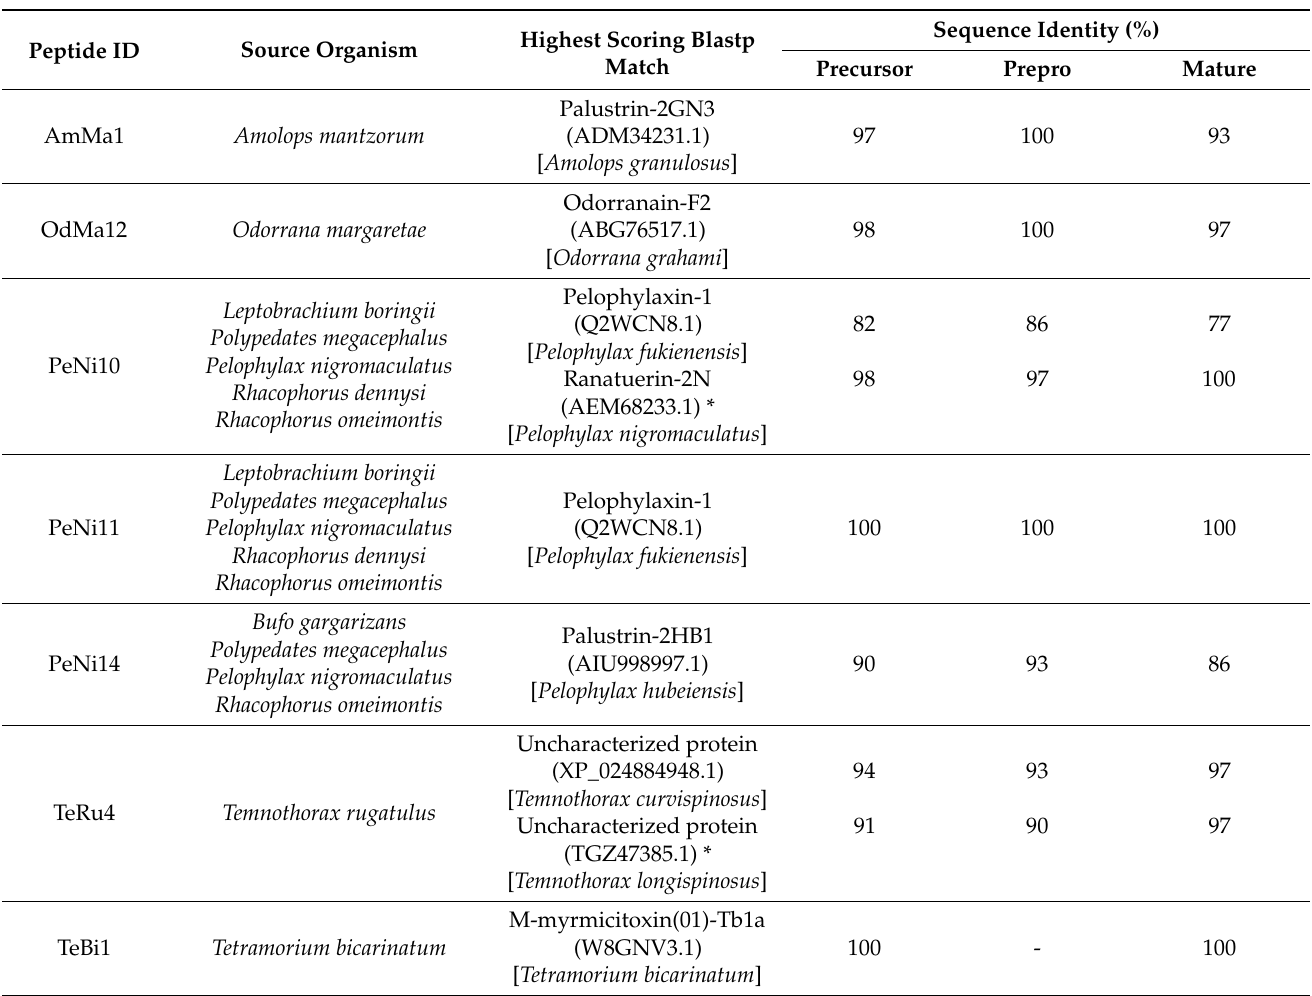
Table 2. Comparison of sequence identities (%) of the discovered AMPs with their best-known AMP blastp matches to the NCBI non-redundant (nr) protein database over the entire sequence (precursor), prepro or mature